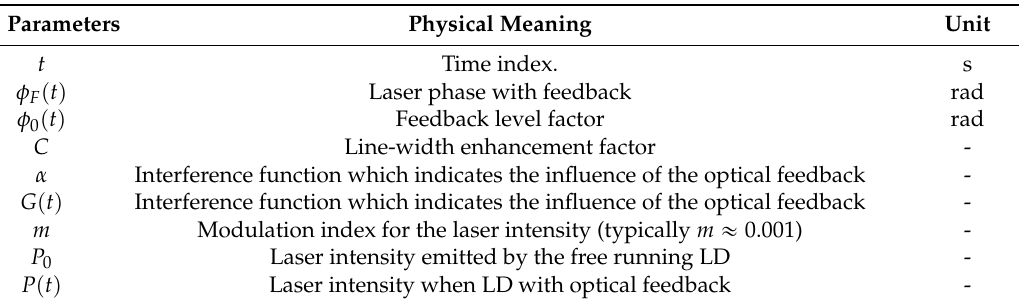
Table 1. Physical meanings of Parameters.